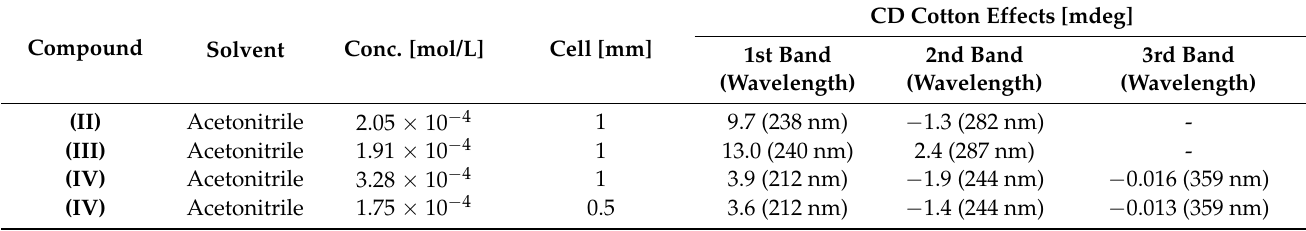
Table 1. CD data for steroidal quinoxalines (II), (III), and